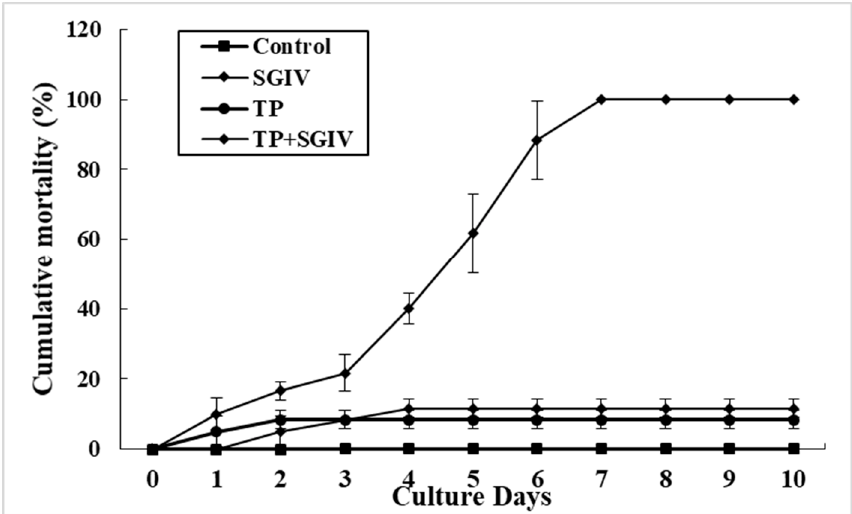
Figure 9. Cumulative mortality over 10 days.